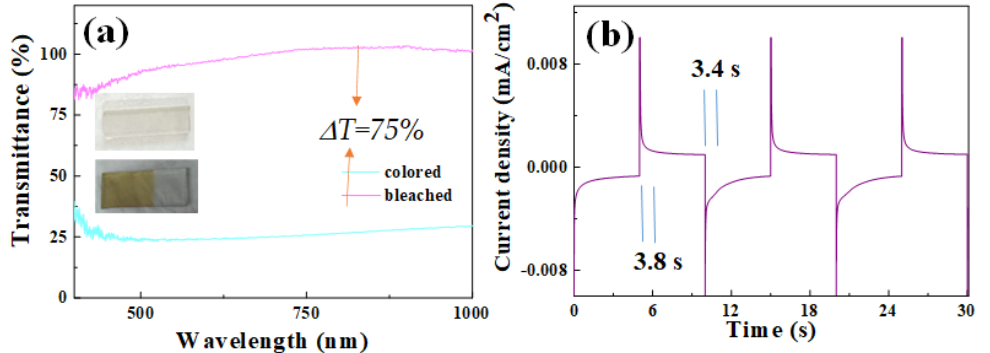
Figure 4. ( a ) Optical transmittance spectra of the Co 3 O 4 nanomaterials. The inset shows the photo- graphs of the Co 3 O 4 nanomaterials in the colored and bleached states. ( b ) Switching response curves of the Co 3 O 4 nanomaterials.